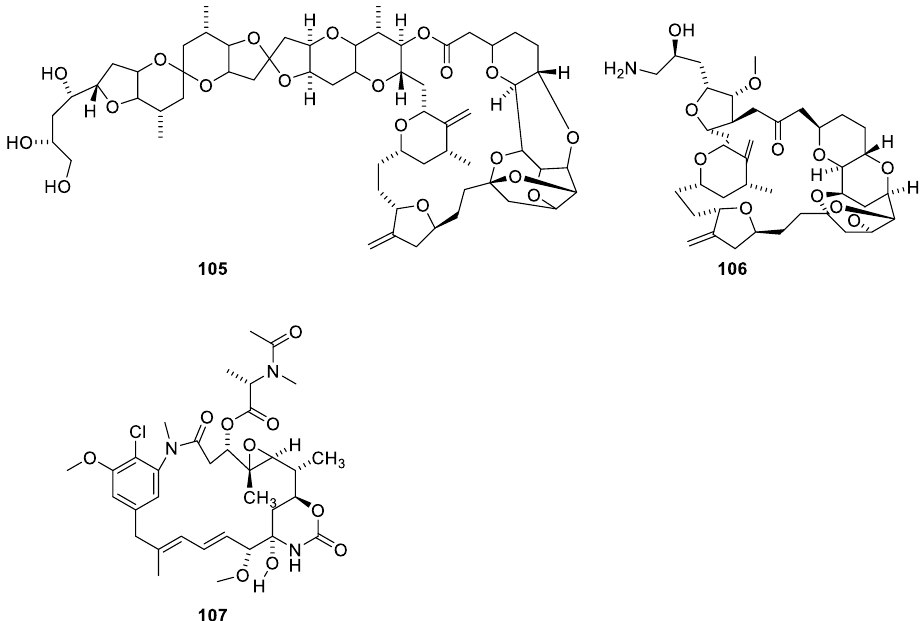
Figure 28. Halichondrin B ( 105 ) and a simplified analogue, eribulin ( 106 ), approved for treatment of breast cancer. Maytansine 1 ( 107 ) conjugated via a linker to an antibody-targeting HER-2 has been approved for treatment of breast cancer [21].